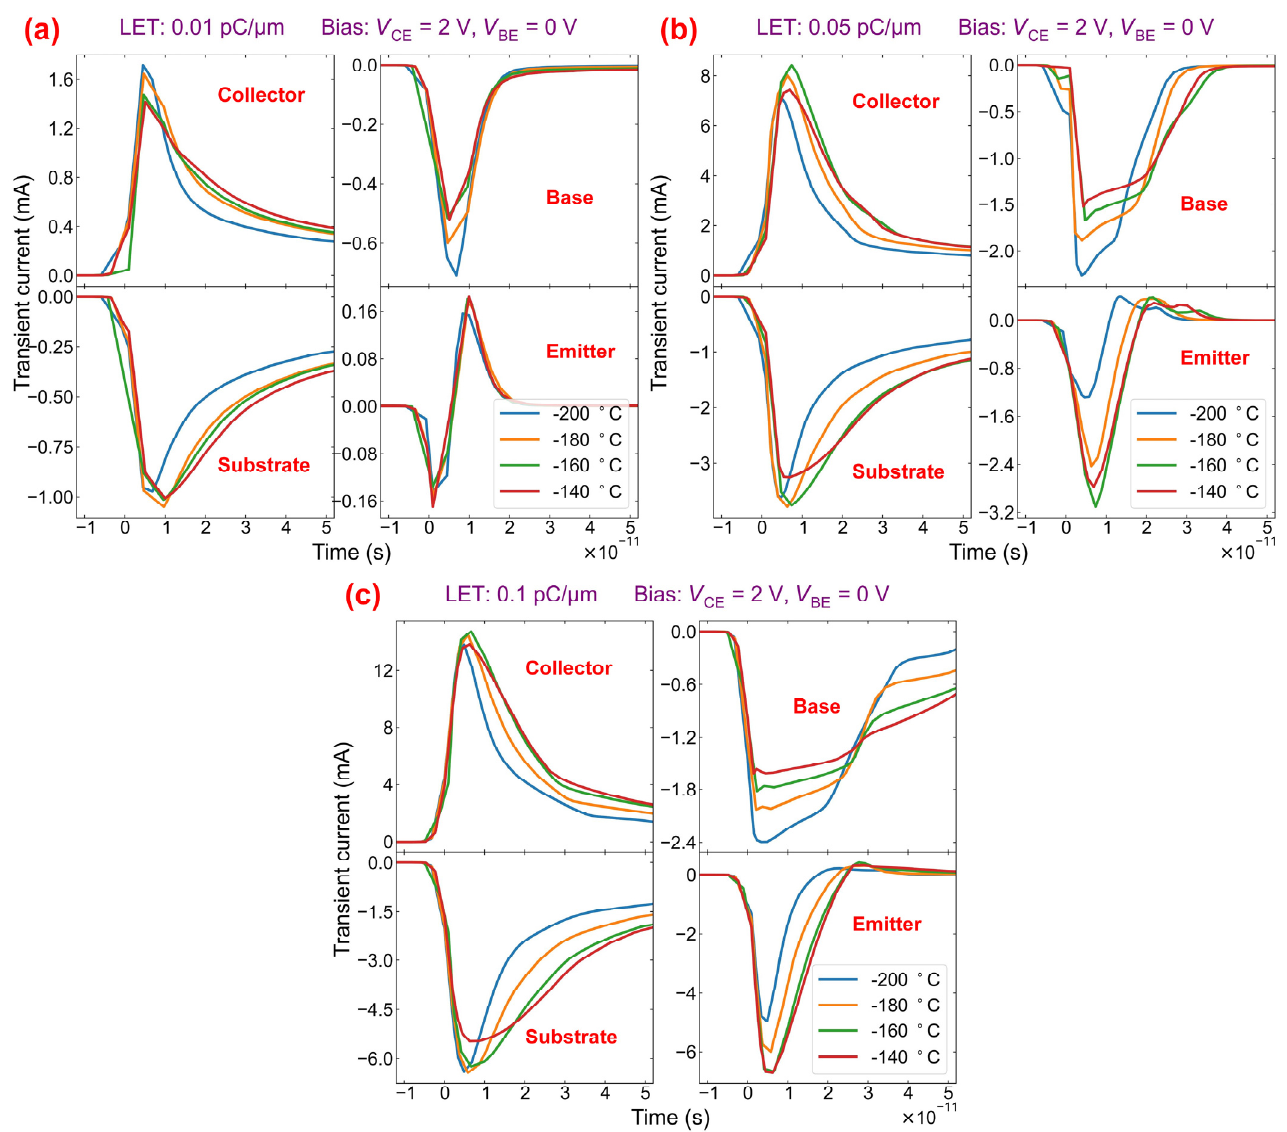
Figure 4. The transient current of the four device electrodes from the TCAD simulation at cryogenic temperatures when the LETs are ( a ) 0.01 pC/ µ m, ( b ) 0.05 pC/ µ m and ( c ) 0.1 pC/ µ m,